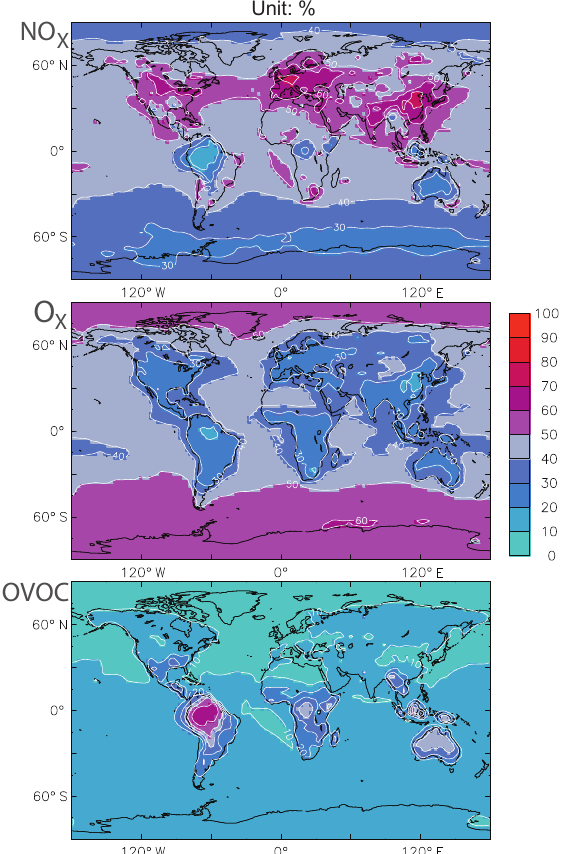
Figure 10. Fractional contributions to the OH recycling probabil- ity (% of r ) in the troposphere by the NO x (top), O x (middle) and OVOC (bottom) mechanisms (the sum of all three panels is